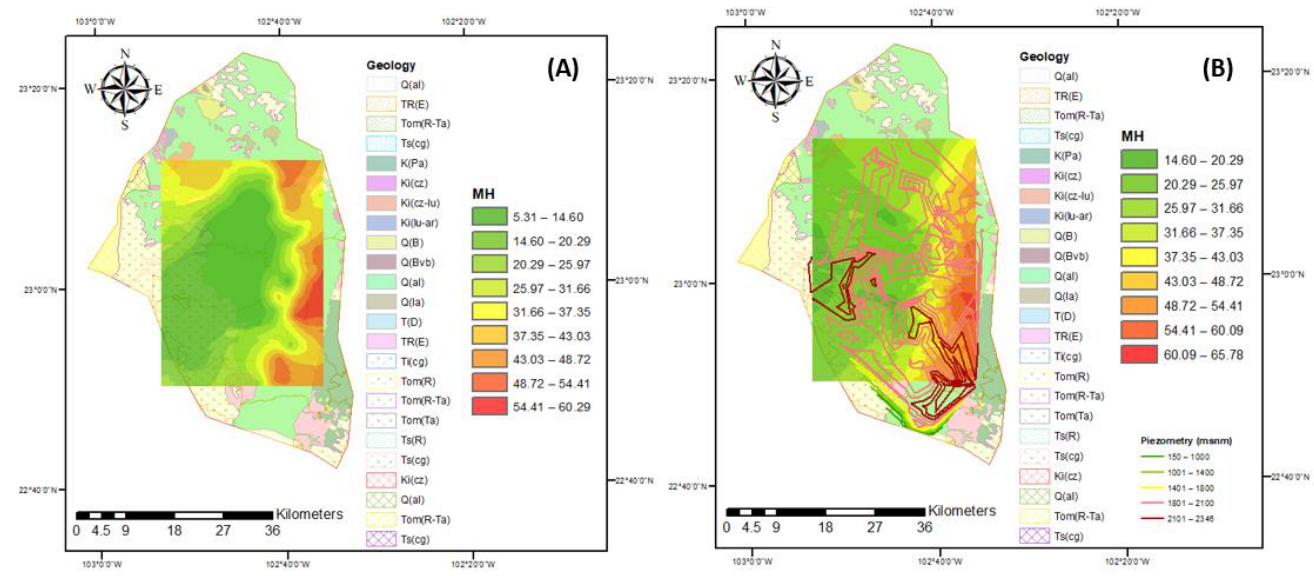
Figure 10. MH index for the years ( A ) 2005 and ( B ) 2015.